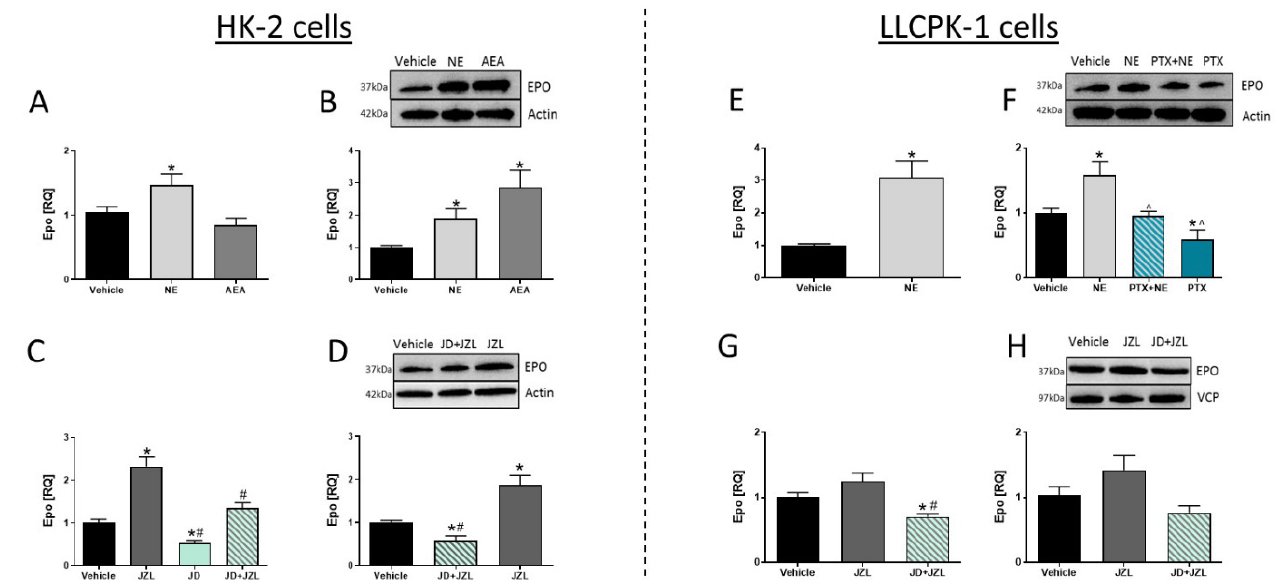
Figure 6. CB 1 R modulates EPO levels in vitro. mRNA expression levels of EPO in HK-2 cells ( A , C ). Representative Western blots and quantification of EPO in HK-2 cells ( B , D ). mRNA expression levels of EPO in LLCPK-1 ( E , G ). Representative Western blots and quantification of EPO in LLCPK-1 cells ( F , H ). Data represent the mean ± SEM from 2–4 independent experiments conducted in 6 replicates in each treatment group, * p < 0.05 vs. vehicle, # p < 0.05 vs. JZL-195, ^ p < 0.05 vs. noladin ether (NE).